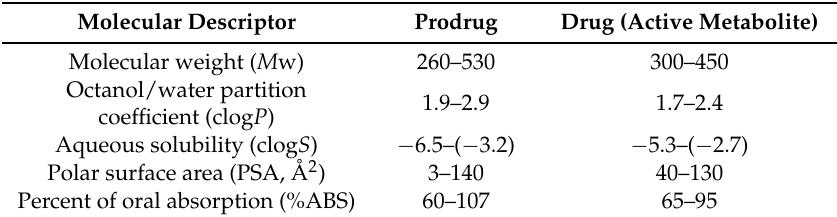
Table 6. Drug-like properties of the antiplatelets